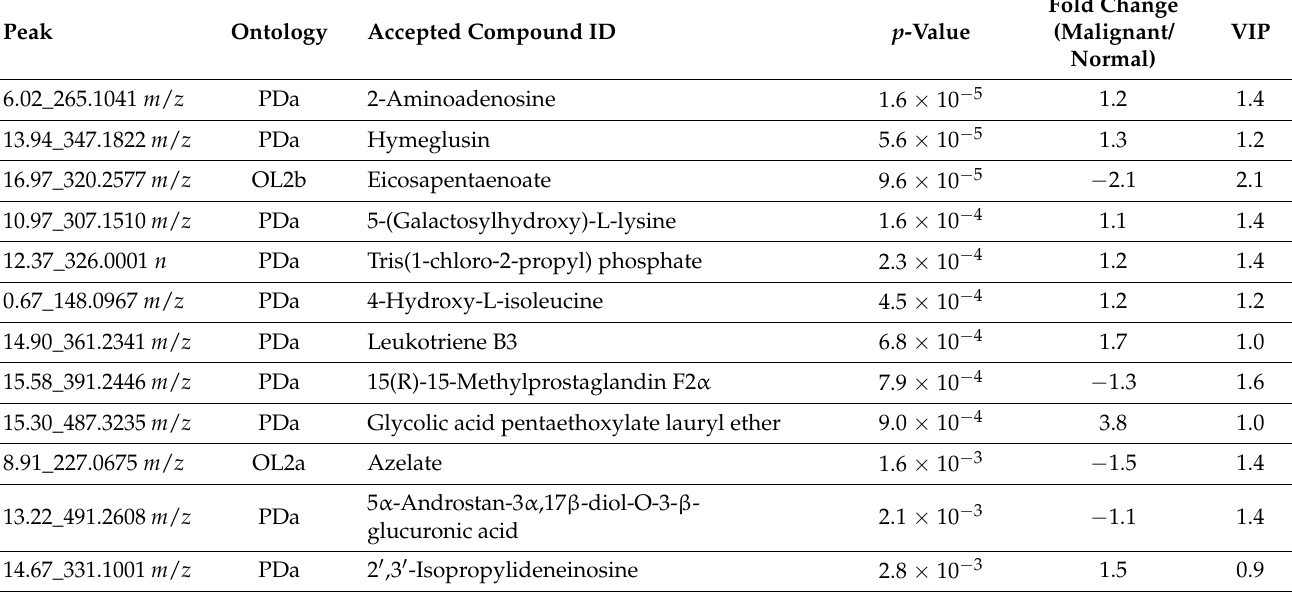
Table 6. Top 50 significantly altered metabolites between malignant and normal oral tissues.